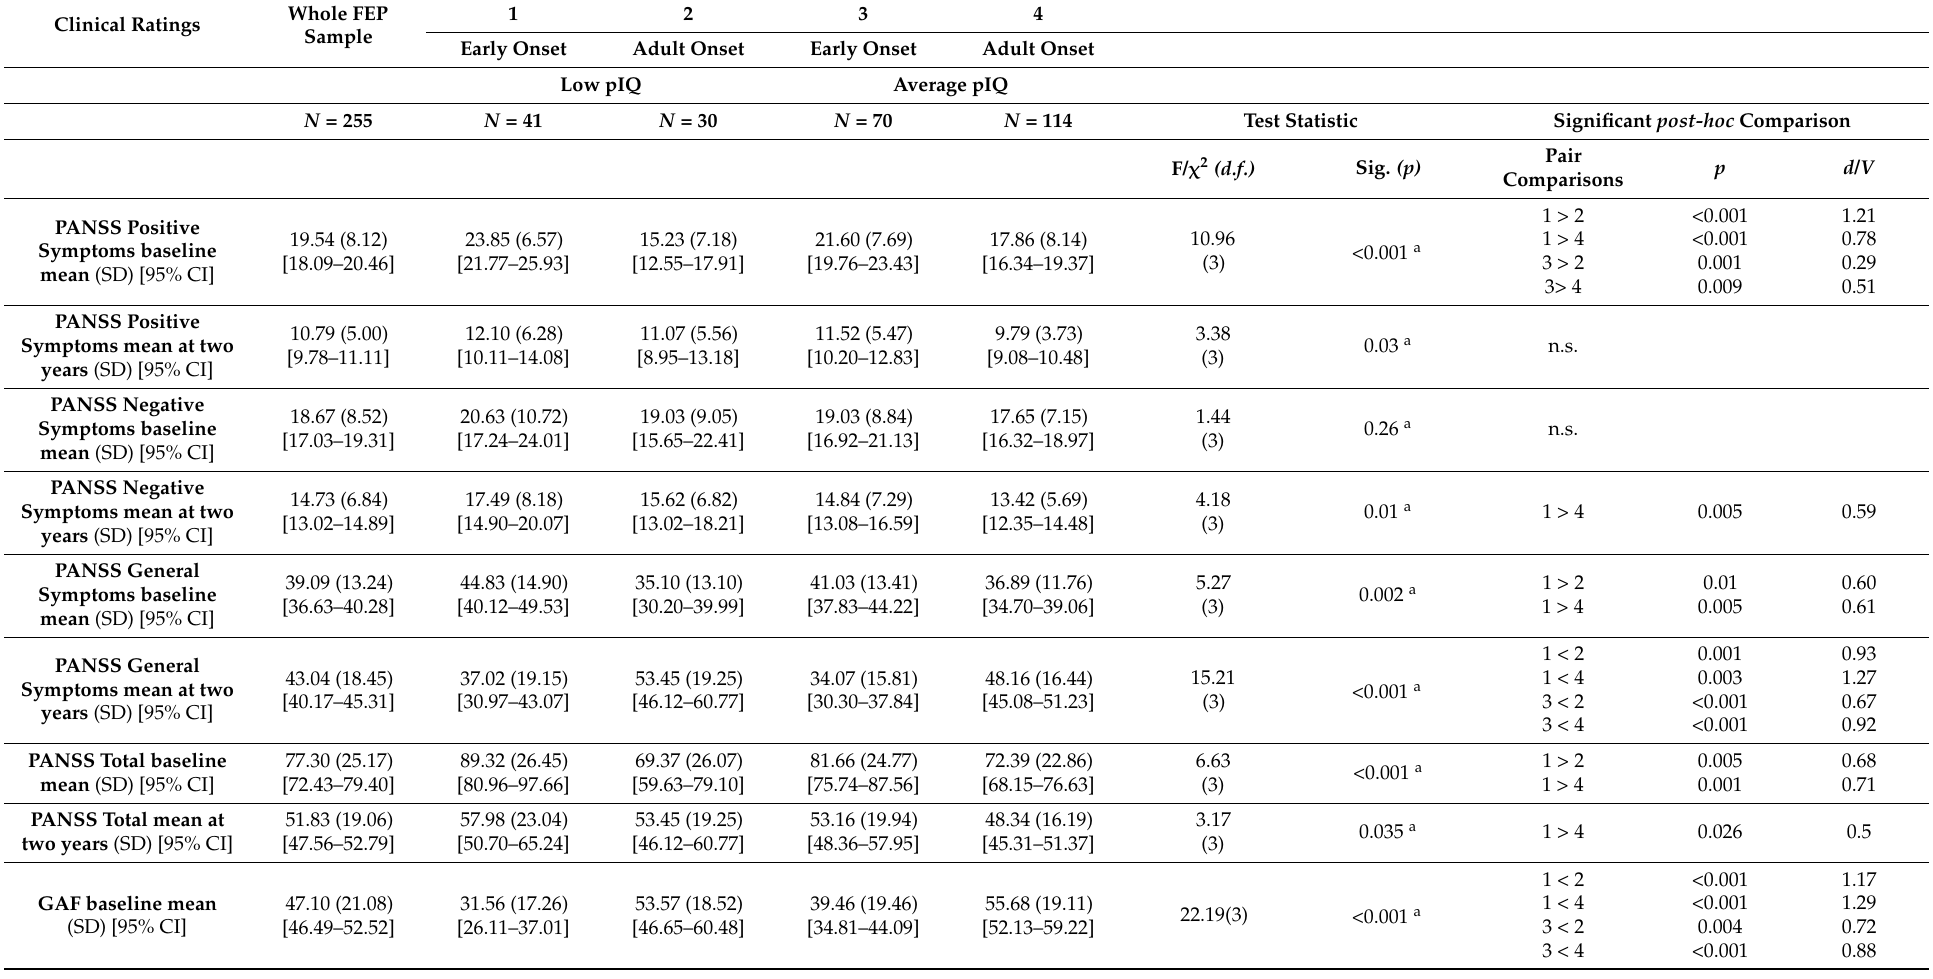
Table 2. Clinical and functional characteristics of the sample of individuals who have experienced a first episode of psychosis and differences among subgroups classified as: early-onset with low-pIQ, adult-onset with low-pIQ, early-onset with average-pIQ, adult-onset with